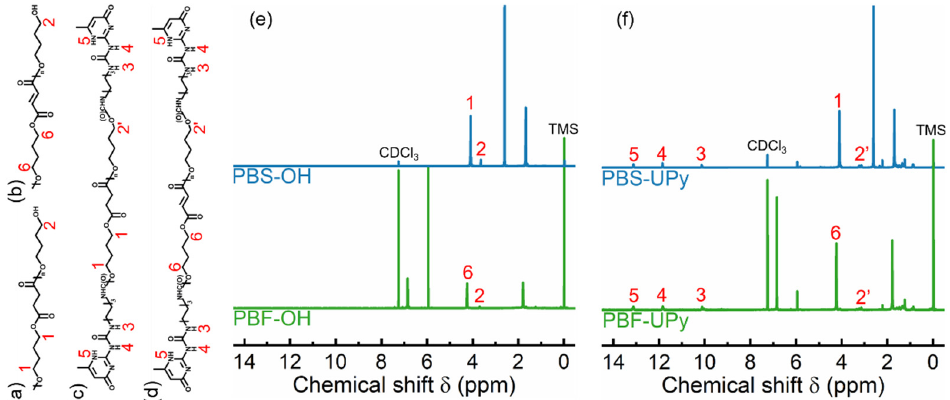
Figure 1. Chemical structures of PBS-OH ( a ), PBF-OH ( b ), PBS-UPy ( c ), and PBF-UPy ( d ), and their 1 H NMR spectrum ( e , f ).